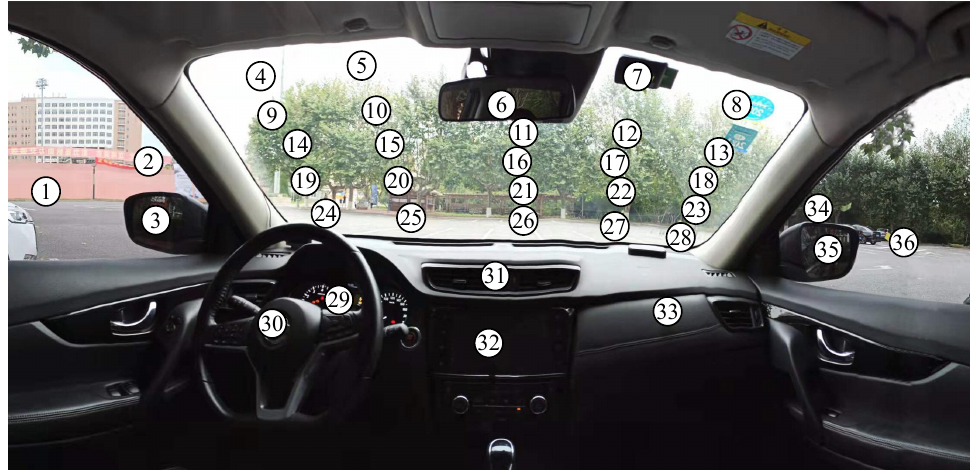
Figure 3. Target gaze zone partition of the on-the-road area. Gaze zone 1–36 are the target regions in the front of the